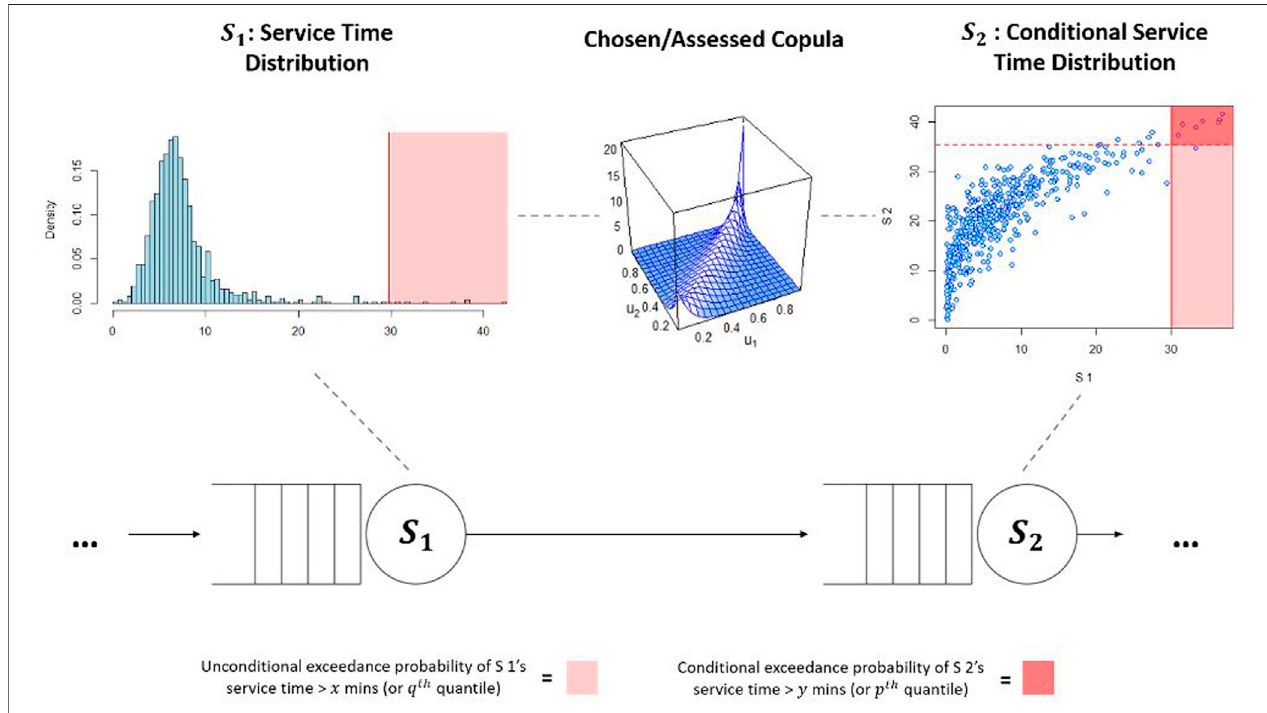
FIGURE 2 | Schematic representation of conditional service time simulation from a